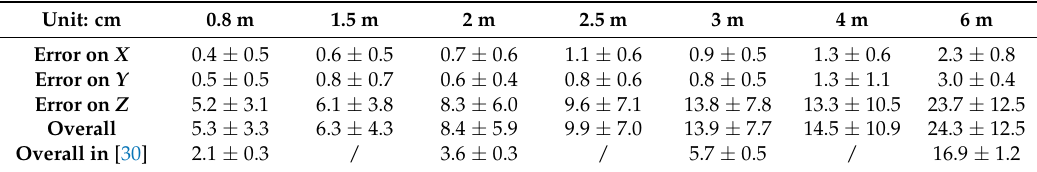
Table 2. Average errors in centimeters measured as the difference between the estimated PoR by the proposed method and the 3D coordinates of the calibration target solved by the test camera. Unit: